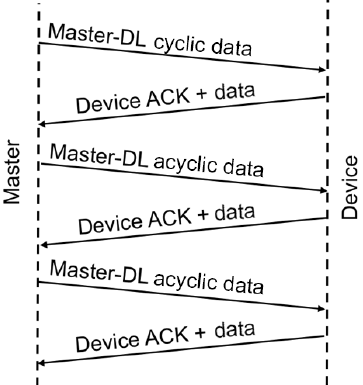
Figure 6. Cyclic and acyclic data transfer interwoven in one RF cycle.